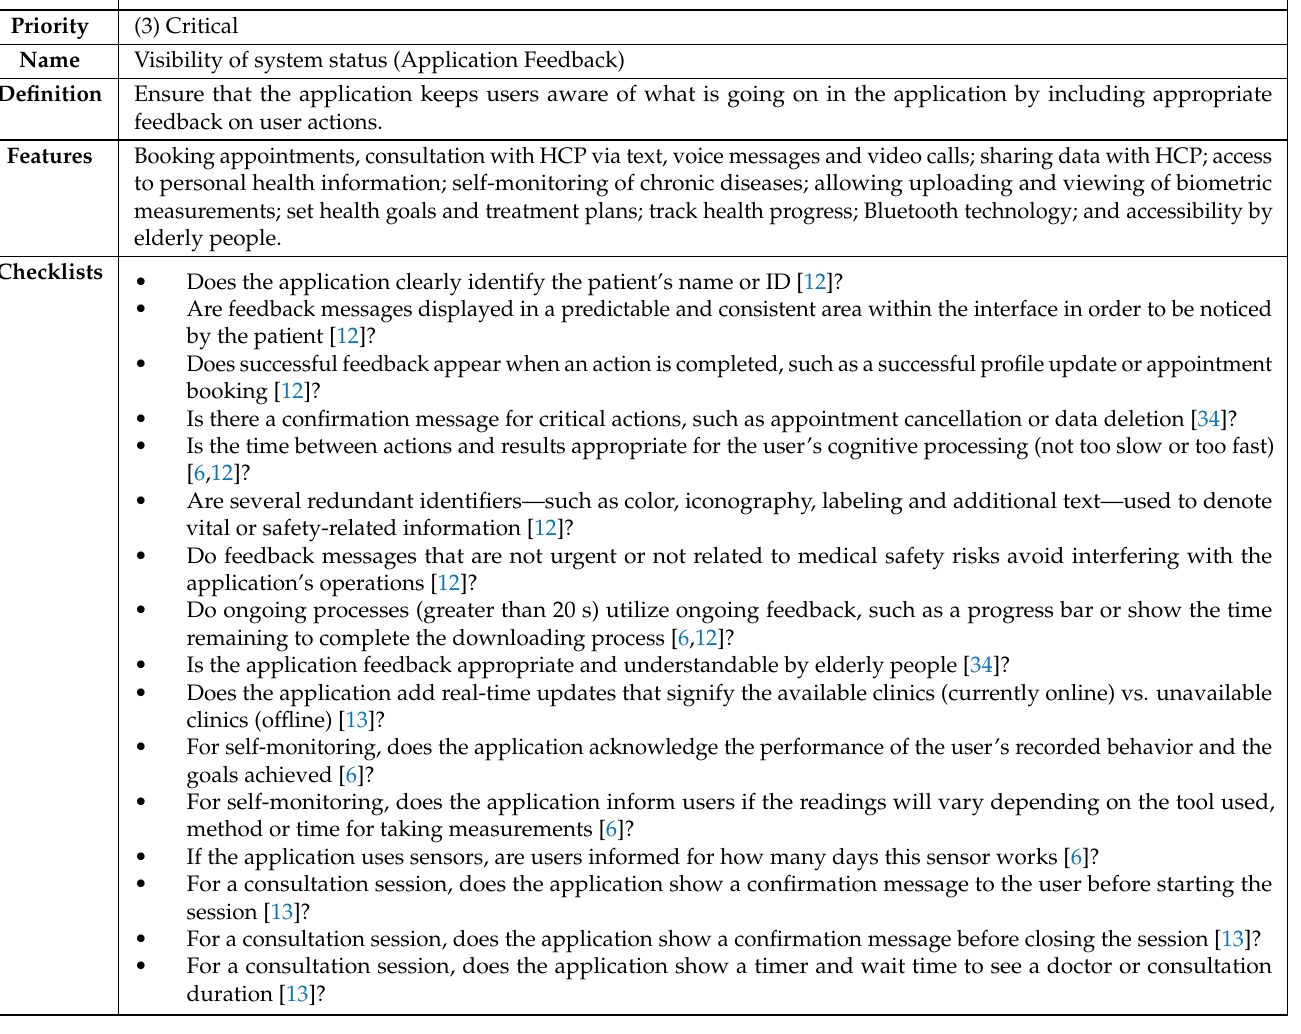
Table A1. Descriptive details of the first guideline.